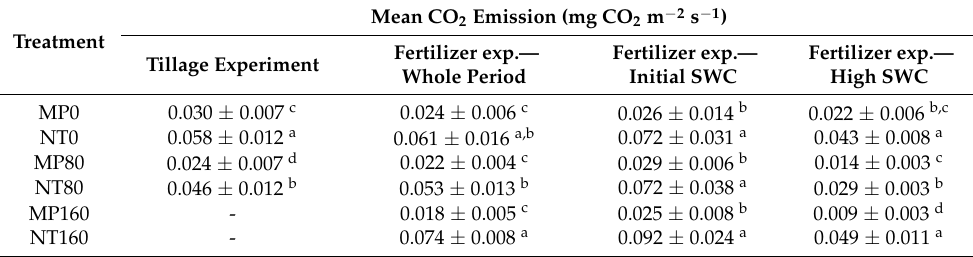
Table 6. Mean CO 2 emission ( ± SD) of soil column experiments. Treatment